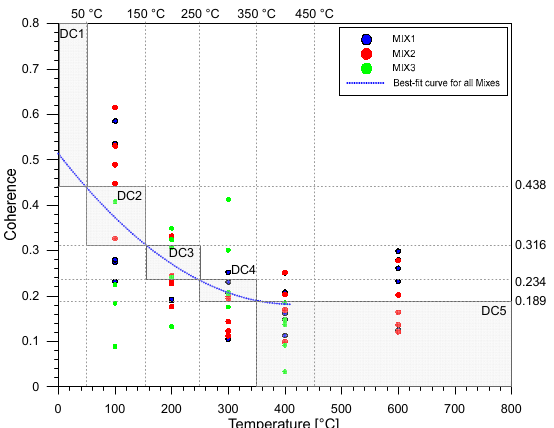
Figure 10. Variation of coherence with increasing temperatures and their corresponding classes. Note that DC means damage class of concrete.